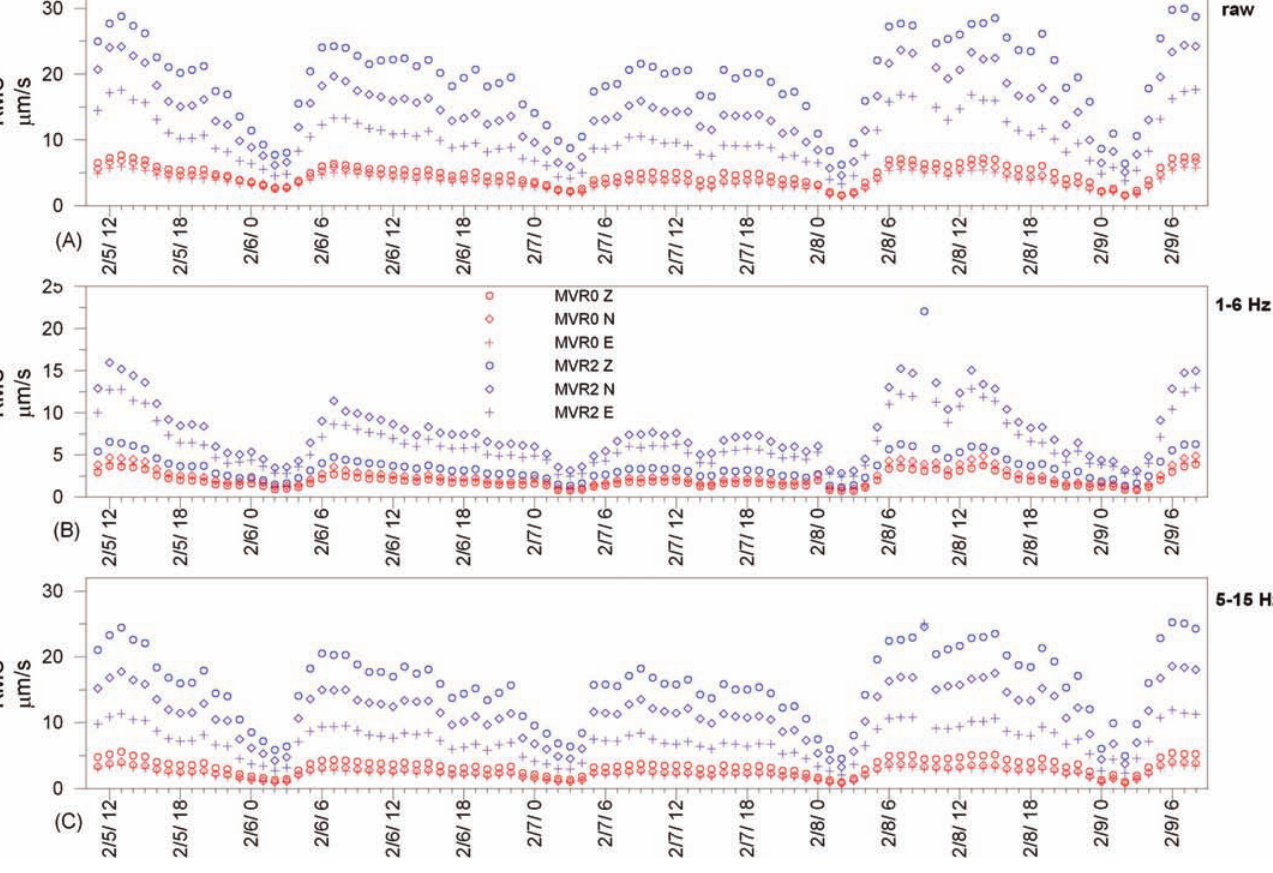
Figure 5. RMS of the noise amplitudes for the three components of the two seismic stations as functions of time. Red symbols, station MRV0. Blue symbols, station MVR2. A) raw signals. B) 1-6 Hz filtered signals. C) 5-15 Hz filtered signals. Each symbol represents the RMS value calculated over a 1-h-long time window. EW, NS and vertical E components as